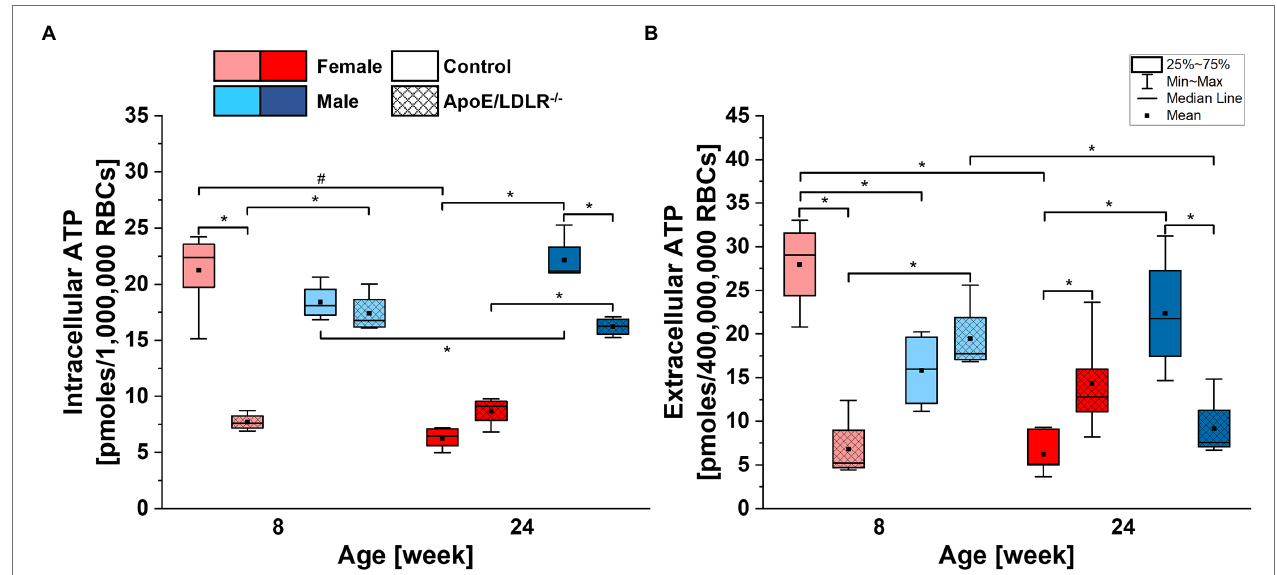
FIGURE 3 | Comparison of basal intracellular (A) and extracellular (B) adenosine triphosphate (ATP) levels of RBCs isolated from 8- and 24-week-old, female and male, control and ApoE/LDLR − / − mice ( n = 4–6). Normality was assessed with Shapiro–Wilk test. The data are expressed as box plots (mean, median, and interquartile range with min–max whiskers) and the significance was calculated using Kruskal–Wallis ANOVA test (* p < 0.05, # p < 0.01). Values were normalized to picomoles per 10 6 RBCs for basal intracellular ATP levels and to picomoles per 4 × 10 8 RBCs for basal extracellular ATP